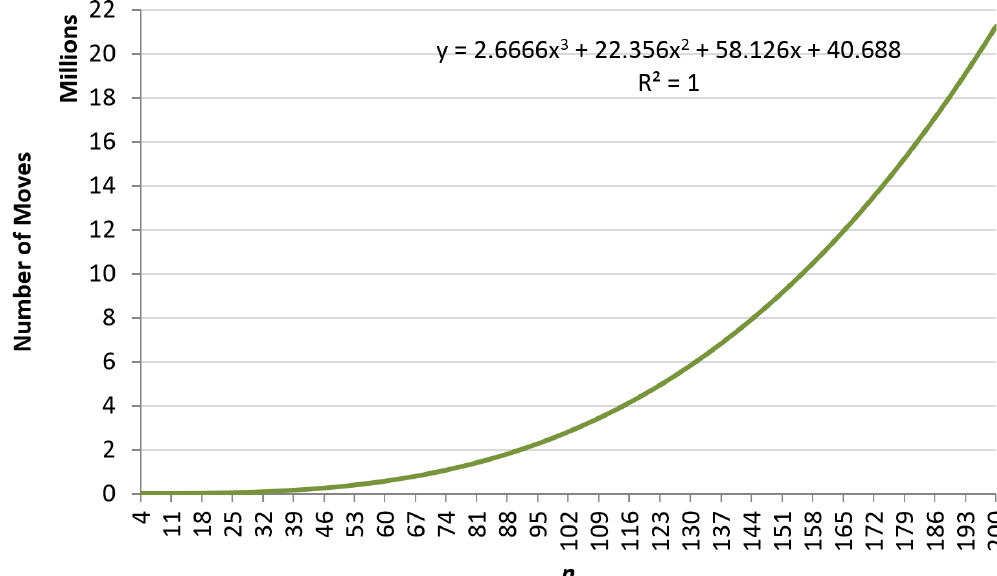
Figure 5. The average number of moves required to solve 10,000 random instances of the ( n 2 − 1) -puzzle for 4 ≤ n ≤ 200 .